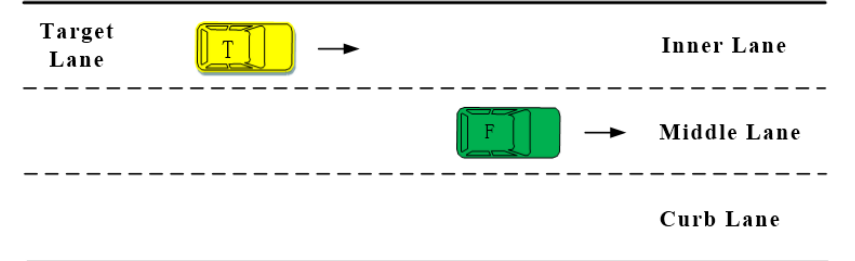
Figure 3. Front extreme moment trial.